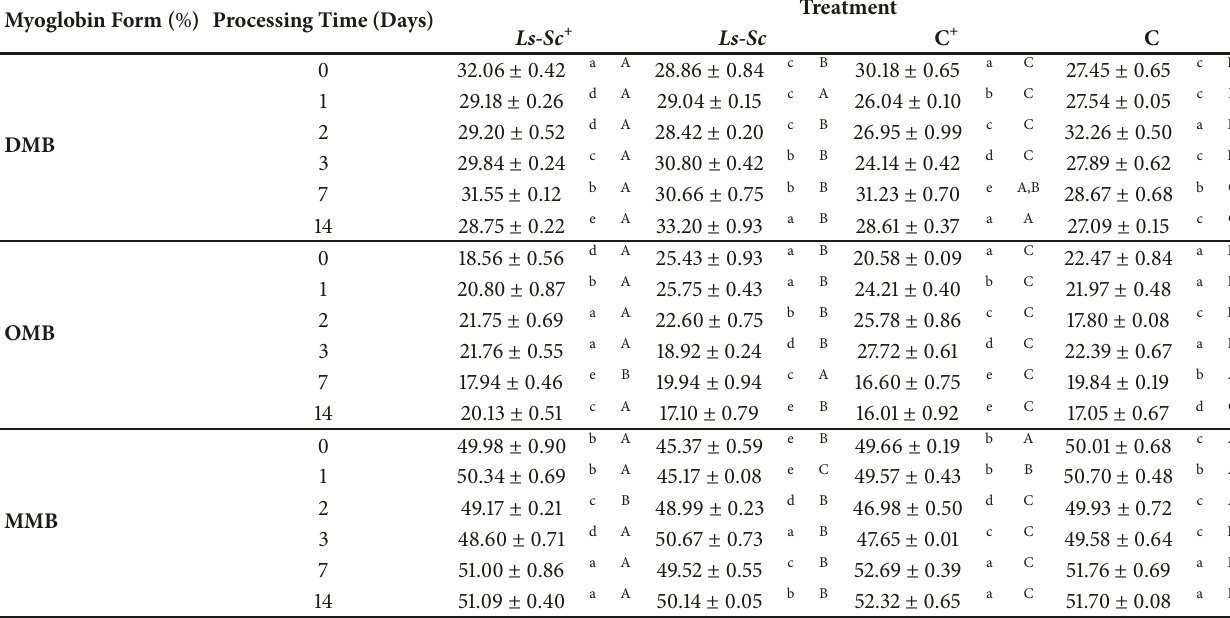
Values are means ± SEM of nine samples with five replicates. a-e Different letters between rows (processing time) for each Myoglobin species show significant differences P < 0.05 by Duncan. A-D Different letters between columns (treatment) for each processing time and Myoglobin species show significant differences P < 0.05 by